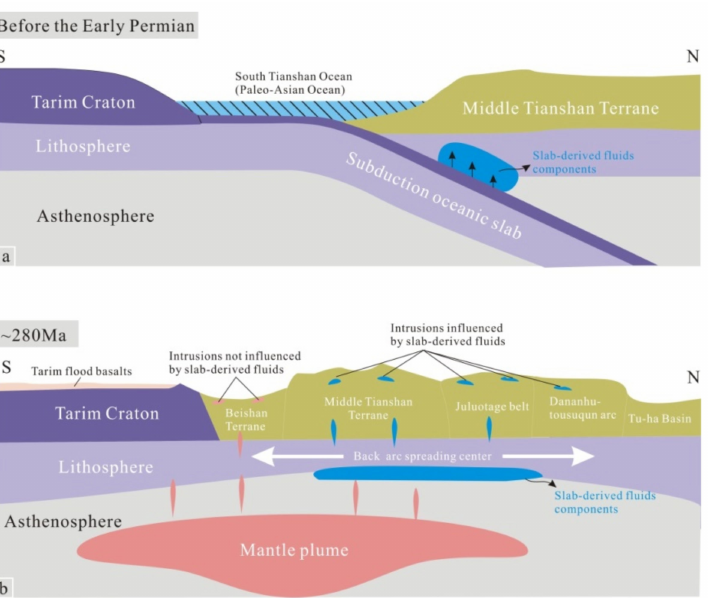
Figure 17. Proposed model showing ( a ) the evolution of the Paleo-Asian Ocean before the Early Permian, ( b ) mantle plume magmatism in the Eastern Tianshan region and the Beishan Rift in ~280